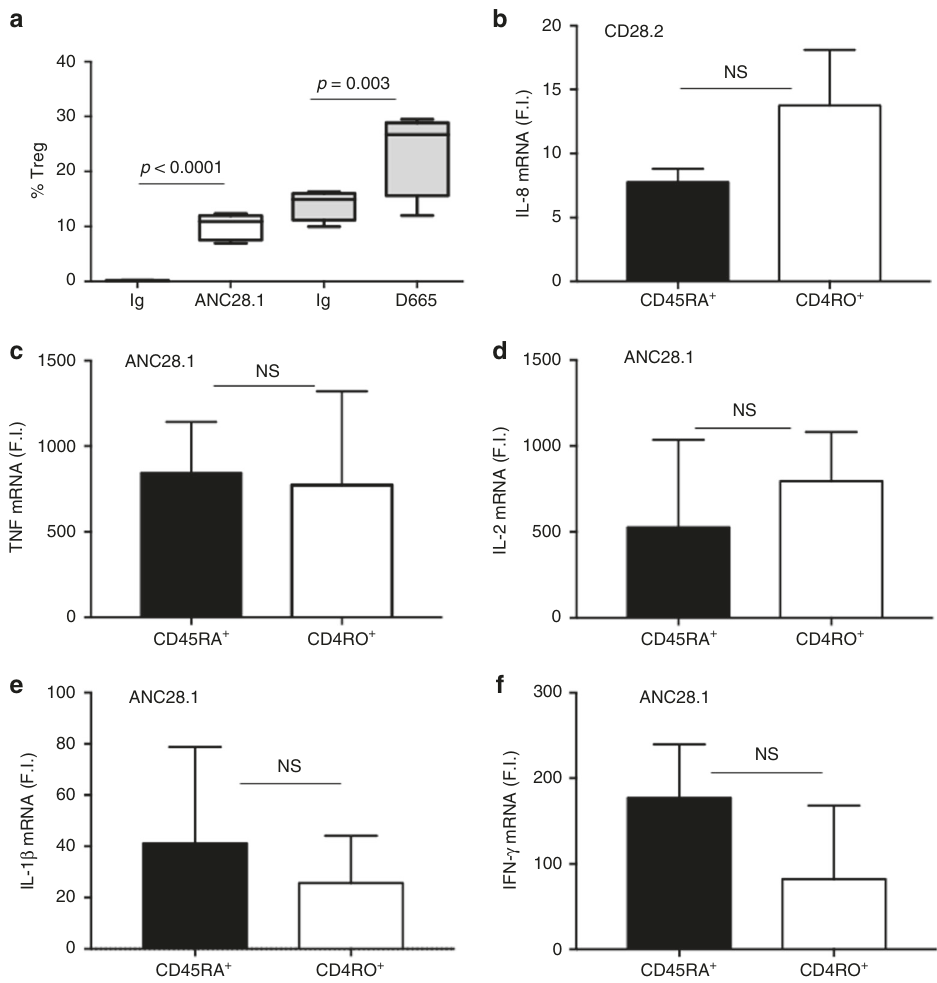
Fig. 2 Differential effects of human and mouse CD28 stimulation in Treg cell expansion and pro-in fl ammatory function of naïve and effector CD4 + T cells. a CD4 + CD25 high FOXP3 + Treg expansion by 2 μ g ml − 1 isotype control Abs (Ig) or superagonistic anti-CD28 Abs (ANC28.1 or D665) in CD4 + T lymphocytes from human HD ( n = 5) or mouse ( n = 4). The percentage of CD4 + CD25 high FOXP3 + Treg cells were calculated. Lines represent mean values ± SD and p- values were calculated by Student ’ s t- test. mRNA levels of IL-8 ( b ), TNF ( c ), IL-2 ( d ), IL-1 β ( e ), and IFN- γ ( f ) in naïve (CD45RA + ) or effector/memory (CD45RO + ) CD4 + T cells from HD ( n = 3) stimulated for 1 h ( c , e ) or 6 h ( b , d , f ) with 2 μ g ml -1 of crosslinked CD28.2 ( b ) or ANC28.1 ( c – f ) Abs. Cytokine mRNA levels were measured by real-time PCR after normalisation to GAPDH (human) or RLP32 (mouse). Fold inductions (F.I.) were calculated over the basal level of cells stimulated with control Ig. Bars indicate mean F.I. ± SD. Statistical signi fi cance was calculated by Student ’ s t- test.